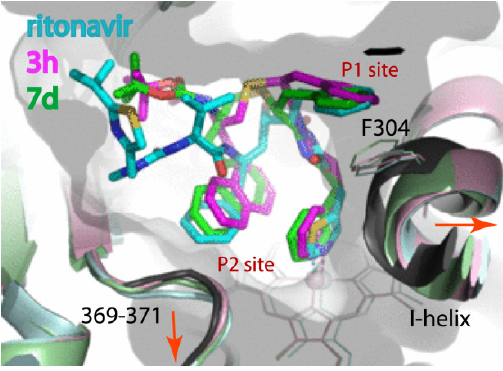
Figure 9. Relative orientation of the best rationally designed inhibitors, 3h and 7d , and ritonavir (3NXU structure; molecule A). The respective structures are coloured in pink, light green and light cyan. Structure of water bound CYP3A4 (5VCC) is rendered in black. Displacement of the I-helix and the 369–371 fragment triggered by the inhibitor binding is indicated by red arrows.